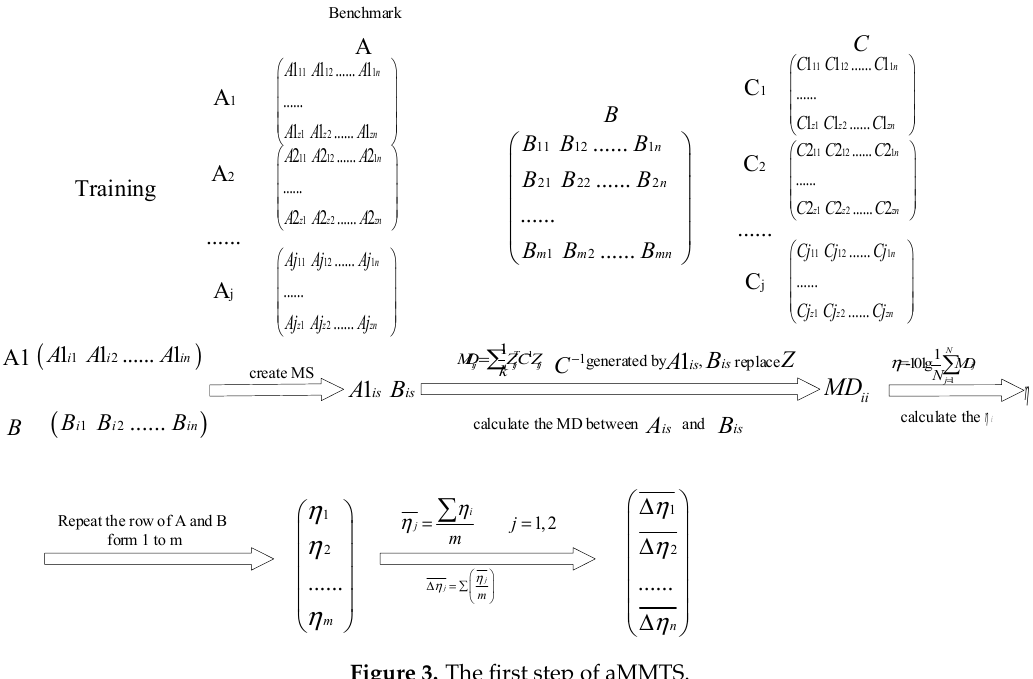
Figure 3. The first step of aMMTS.